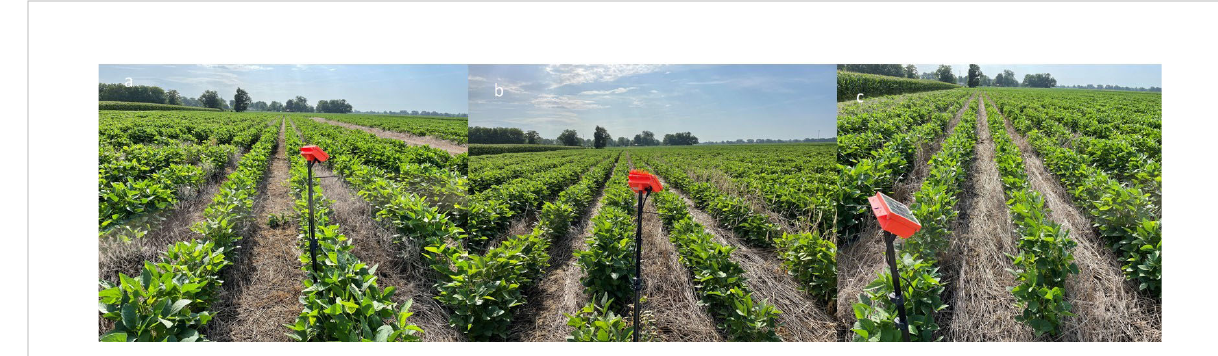
FIGURE 1 Soybean established in three treatments at 30 days after planting: (A) no cover crop, (B) cover crop burndown and rolled, and (A) cover crop rolled green and